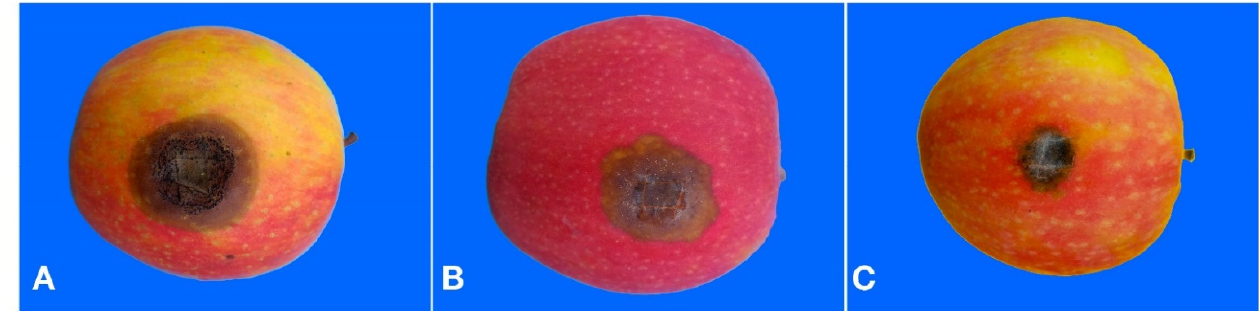
Figure 4. ( A ) Necrotic lesion induced by a Colletotrichum gloeosporioides isolate on a wound inoculated apple seven d.p.i. ( B ) Necrotic lesion induced by the Colletotrichum acutatum reference isolate on a wound inoculated apple seven d.p.i. ( C ) Necrotic lesion induced by a Colletotrichum karstii isolate on a wound inoculated apple seven d.p.i.